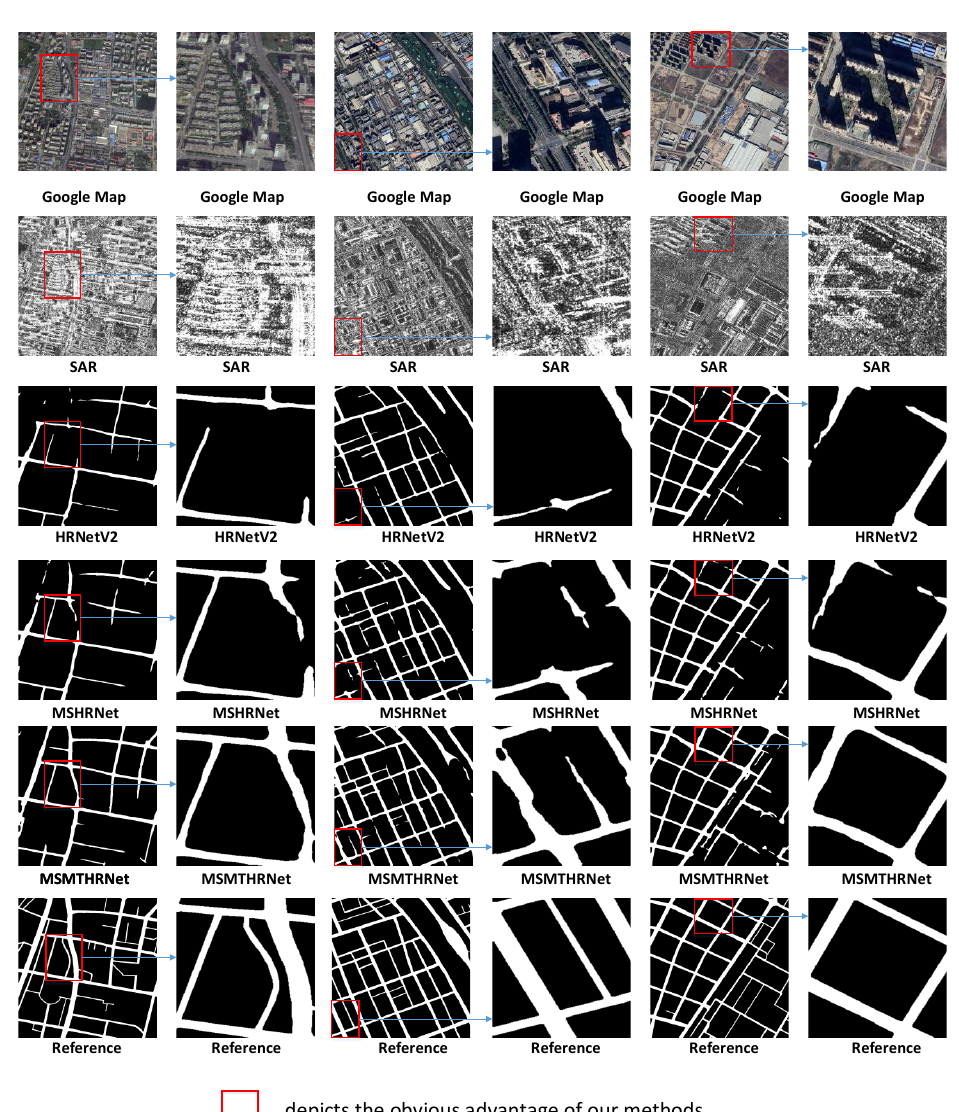
Figure 8. Qualitative comparison of road detection results produced by different methods based on three images from our test